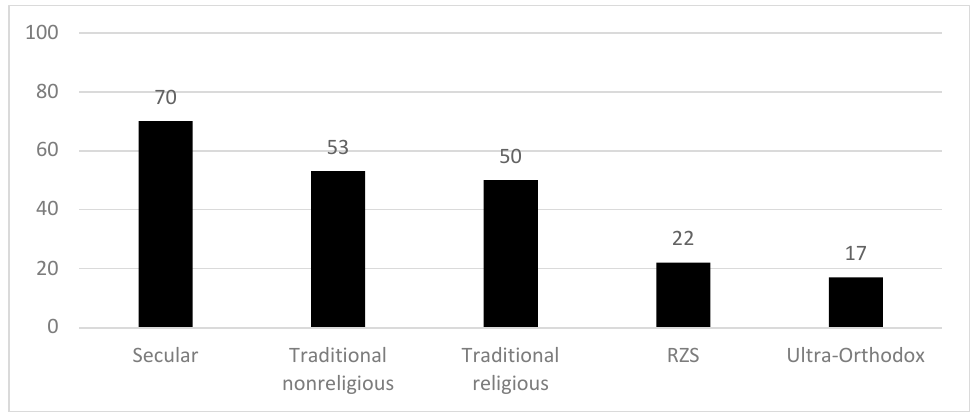
Figure 18. Agree that the Supreme Court should have the authority to abolish laws that were enacted by the Knesset if they were found to be impairing basic democratic values, by level of religiosity (%).